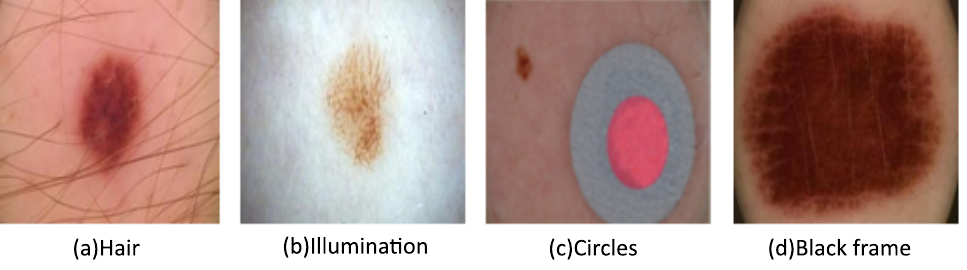
Figure 3. Images with various types of noise from the ISIC